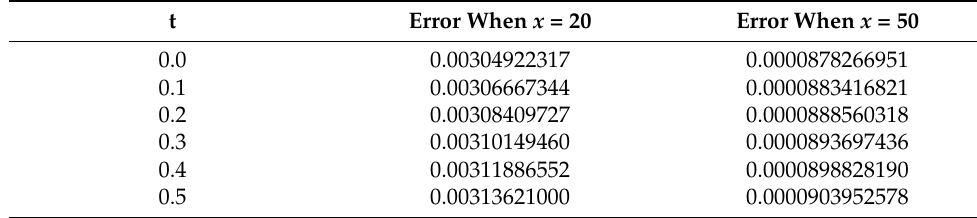
Table 1. Absolute error for Case 1 for x = 20, x = 50.